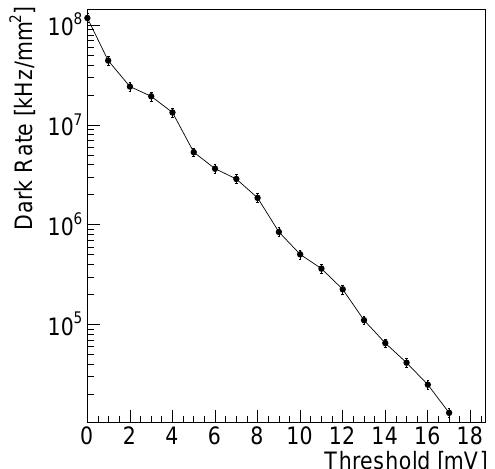
Figure 4. Dependence of the dark count rate of the SiPM prototype versus signal threshold at 14 V (2 V overvoltage) at 25 ◦